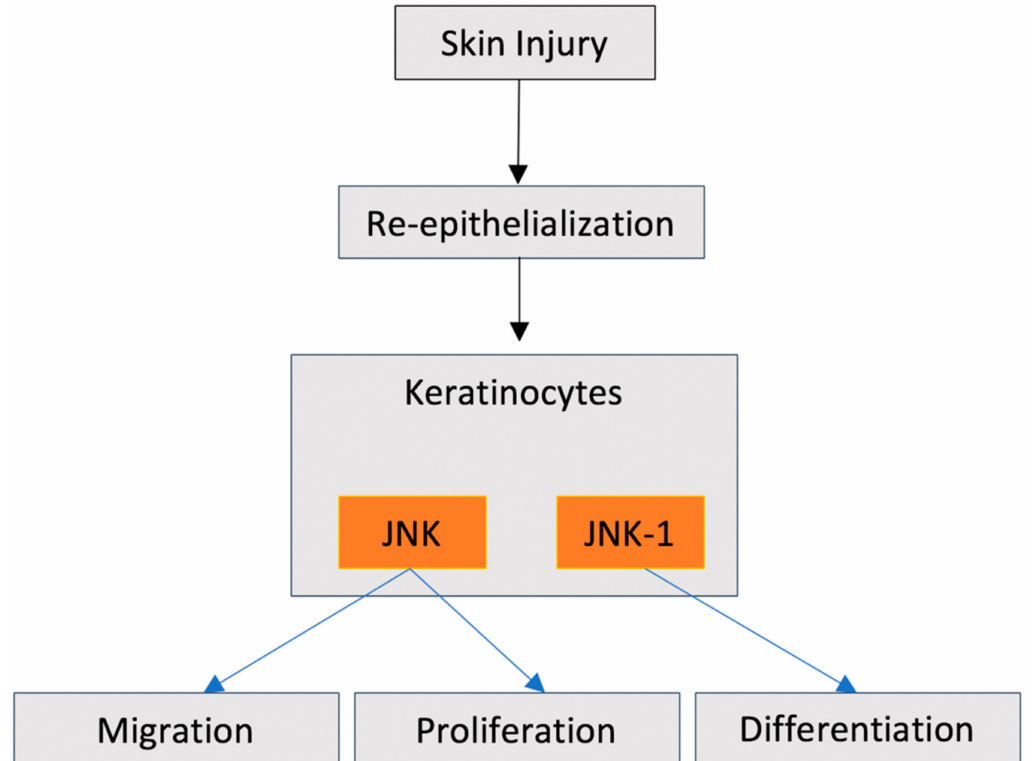
Figure 2. Contrasting roles of JNK signaling in epithelial biology post wounding in skin. JNK-1 has been shown to influence terminal di ff erentiation of keratinocytes, but similarly JNK has been shown to play a role in proliferation and